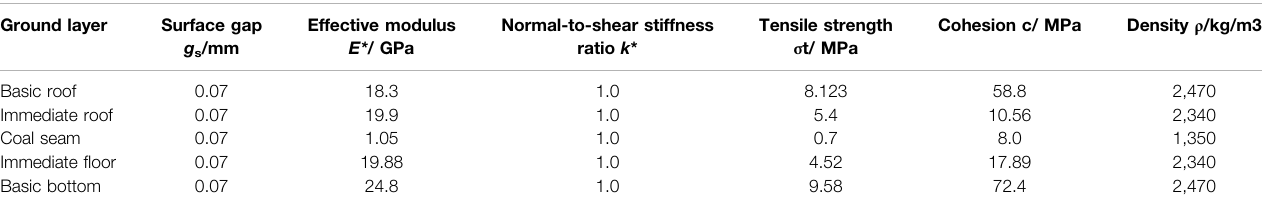
Frontiers in Earth Science |